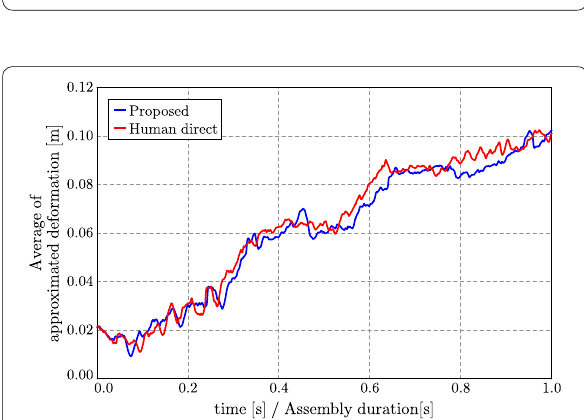
Fig. 10 Average of the approximated deformation of the rubber band over six trials per method. The time is normalized by the assem‑ bly duration time